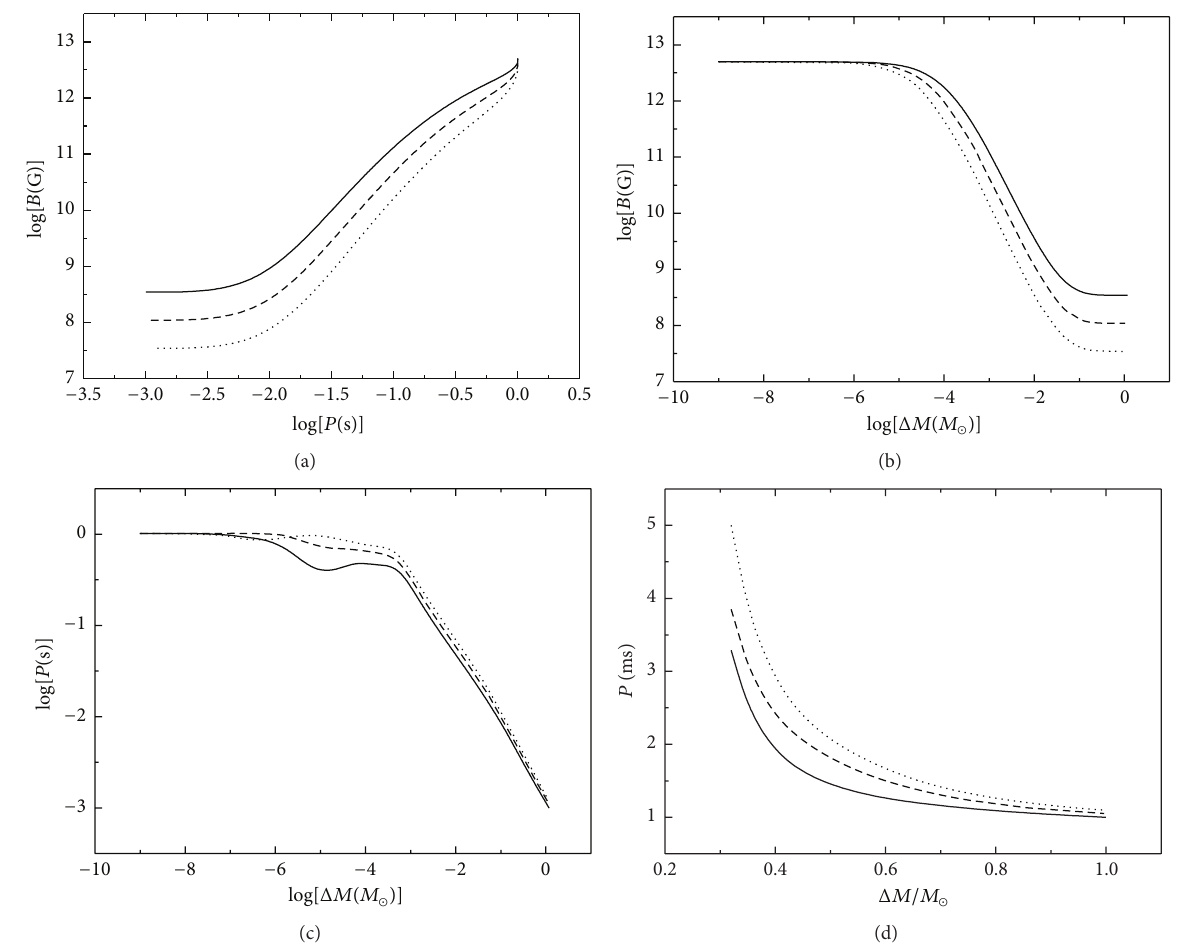
Figure 4: 𝐵 and 𝑃 evolution in the recycling process. (a) shows the joint evolution of 𝐵 and 𝑃 . (b) and (c) are their evolution as a function of accreted mass Δ𝑀 . The solid, dashed, and dotted lines are plotted for an accretion rate of 10 18 g s −1 , 10 17 g s −1 , and 10 16 gs −1 , respectively. Initial values 𝐵 0 = 5 × 10 12 G and 𝑃 0 = 1 s were taken. (d) is a zoom-in view of (c) in a linear scale for spin periods shorter than